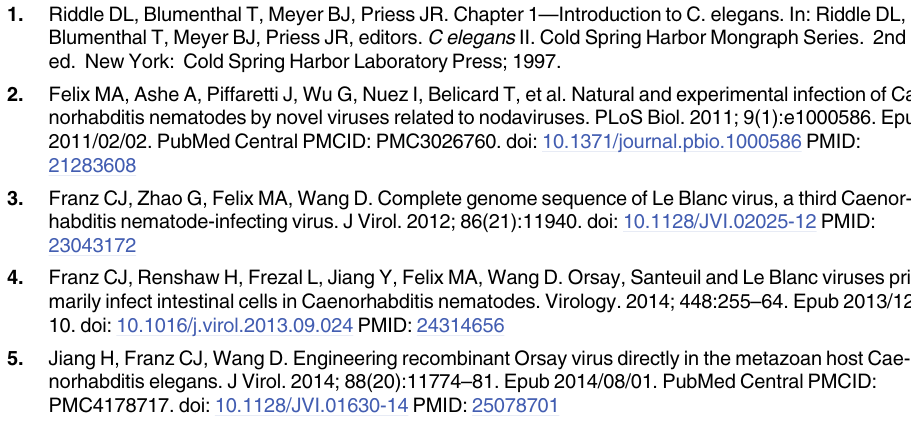
S7 Fig. Multiple transgenic C . elegans lines of recombinant viruses. For each recombinant virus, over 9 independent lines of transgenic C . elegans were screened for infectivity using the transparency test. Most lines showed consistent results. Variations among lines were consis- tent with Jiang et al., 2014 (5). Blue indicates lines used in Fig 5. (TIF) S8 Fig. Stereochemical constraints in the formation of potential CP- δ trimers and penta- mers in the Orsay capsid. (a) An Orsay CP trimer. (b) An Orsay CP pentamer. The C-termi- nus of one CP molecule in the trimer and pentamer is marked with a solid back dot. The dotted curves in (a) and (b) delineate the likely paths that the downstream polypeptides need to undertake in order to form a trimeric and a pentameric CP- δ fiber, respectively.